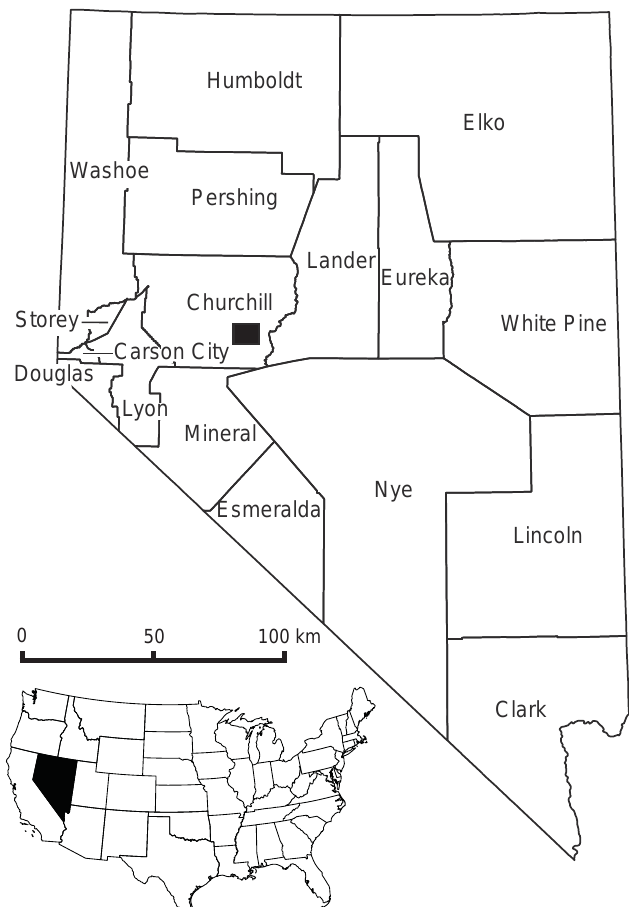
Fig. 1. Map of the United States with the state of Nevada indicated in black, and enlarged map of Nevada, with Eastgate study area indicated as black